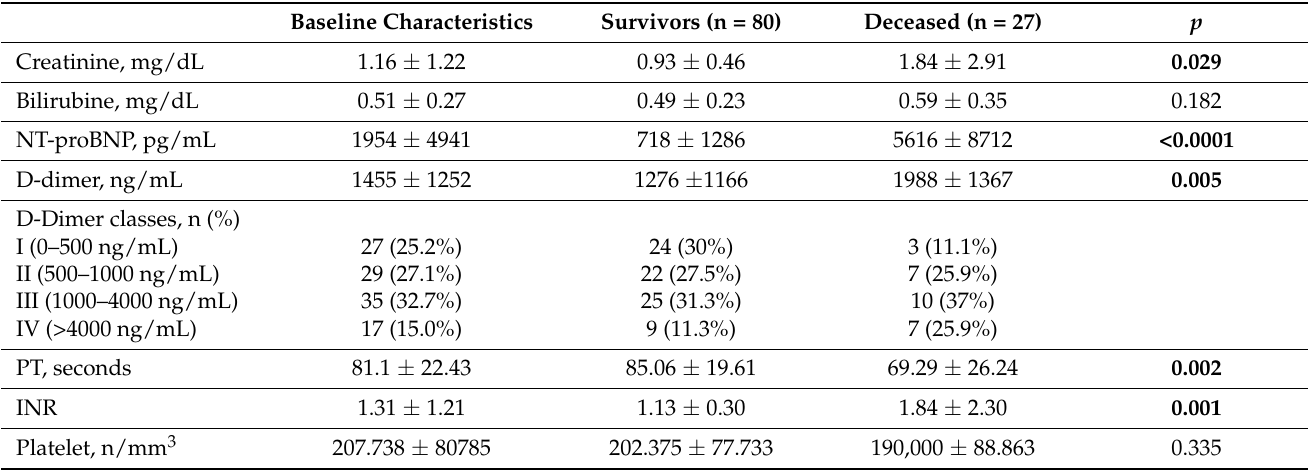
Table 2. Biochemical characteristics of 107 COVID-19 patients included in the study.